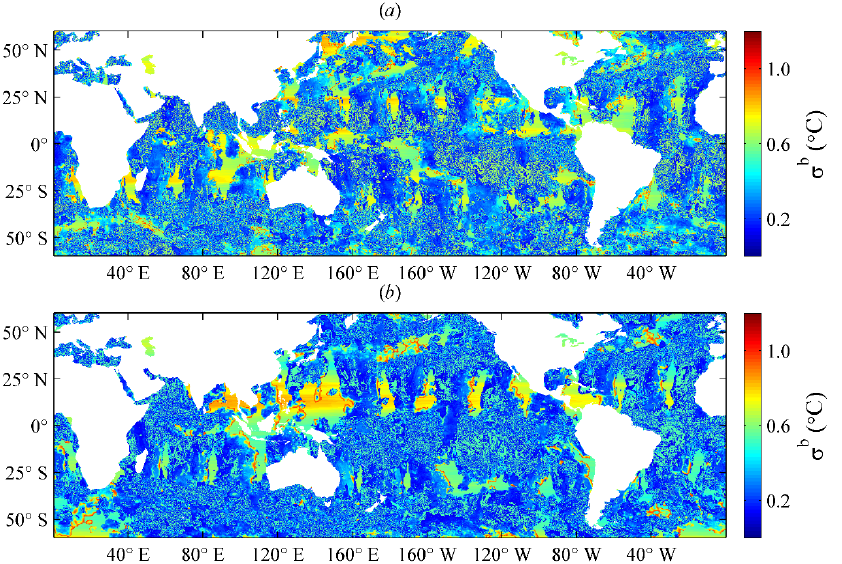
Figure 6. Distributions of SST background error on ( a ) 1 May 2016, and ( b ) 1 October 2016.